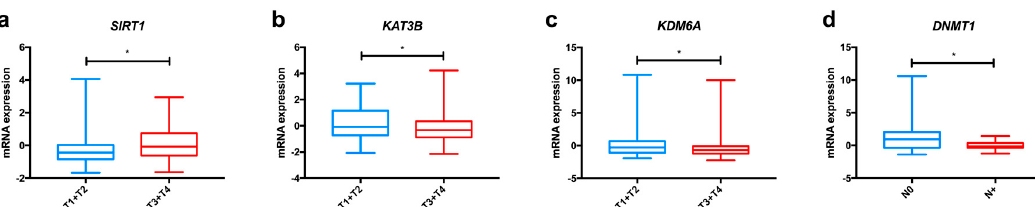
Figure 3. Relevant variations in the expression of enzymes involved in epigenetic alterations in oesophageal cancer, based on TCGA data analysed through the cBioPortal for Cancer Genomics resource. Di ff erences in mRNA expression of KAT3B ( a ), SIRT1 ( b ) and KDM6A ( c ) between early tumour stages (T1 + T2) and advanced tumour stages (T3 + T4); Di ff erences in mRNA expression of DNMT1 ( d ) between tumours with lymph node invasion and without lymph node